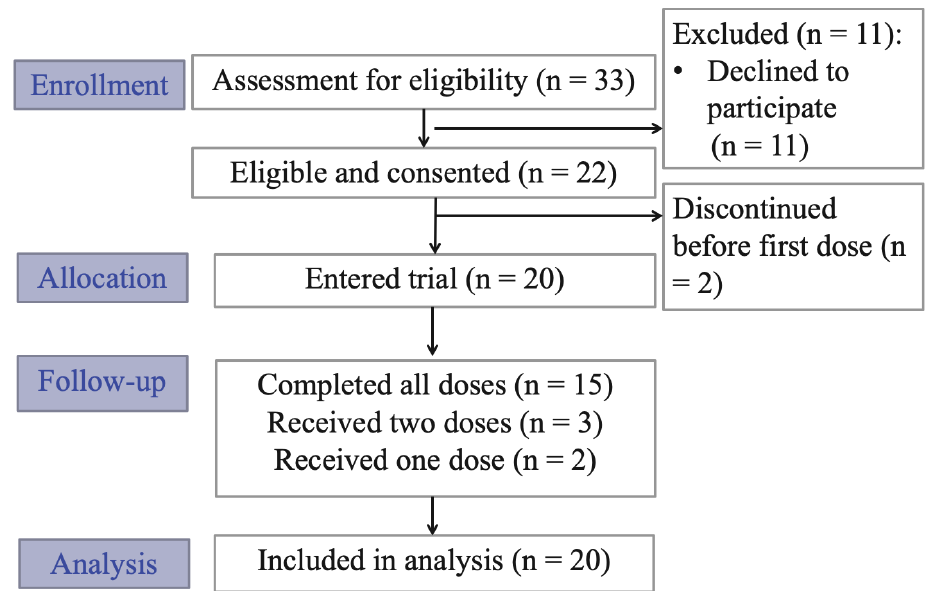
Figure 1. CONSORT clinical trial flow diagram.